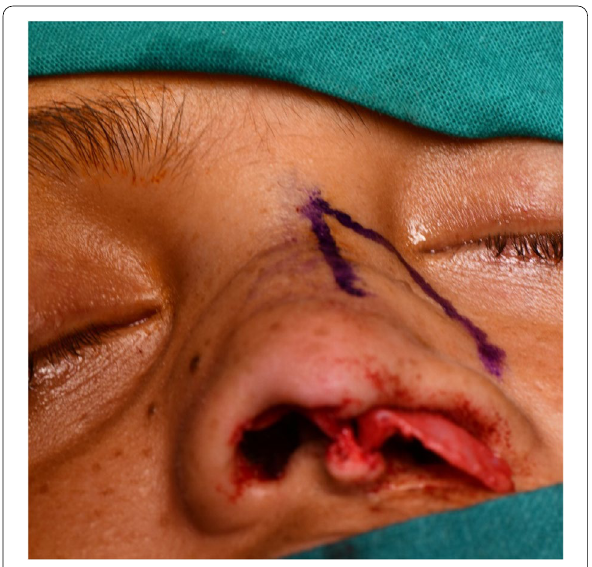
Fig. 3 Extended spreader graft to support and keep the lateralized cleft side in the elevated